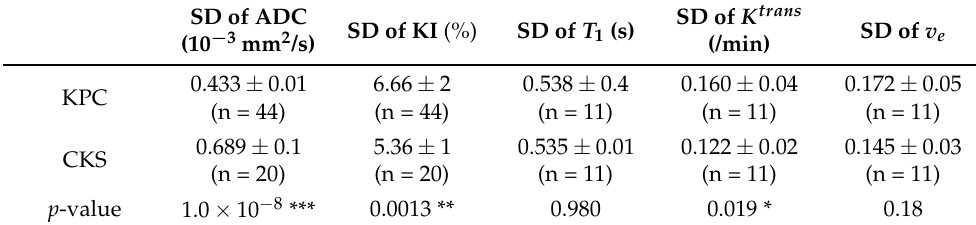
Table 3. Intratumor standard deviations of DW- and DCE-MRI metrics a,b . SD of ADC SD of K trans SD of KI (%) SD of T 1 (s) SD of v e (10 − 3 mm 2 /s) (/min) 0.433 ± 0.01 6.66 ± 2 0.538 ± 0.4 KPC (n = 44) (n = 44) 0.689 ± 0.1 (n = 20) p -value 1.0 × 10 − 8 *** 0.0013 ** 0.980 0.019 *